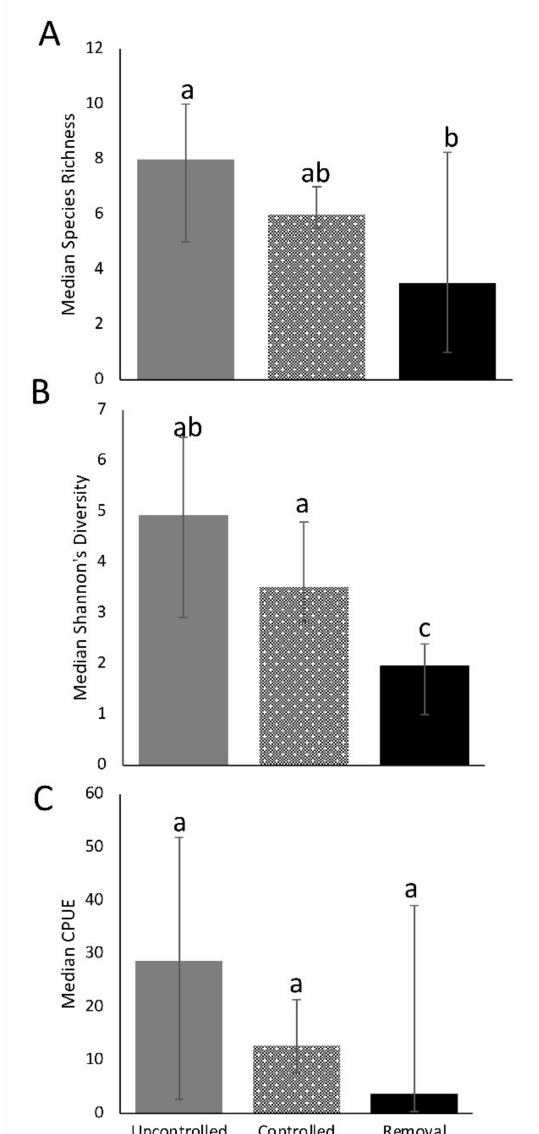
Figure 4. Mussel assemblage metrics downstream of three anthropogenic barriers in the Lake Michigan basin, Michigan, USA. ( A ) Median species richness, ( B ) median Shannon’s diversity, and ( C ) median CPUE. Kruskal–Wallis tests were used among barriers. Error bars represent the 25th and 75th quartiles. Letters above bars indicate statistical significance with Dunn’s